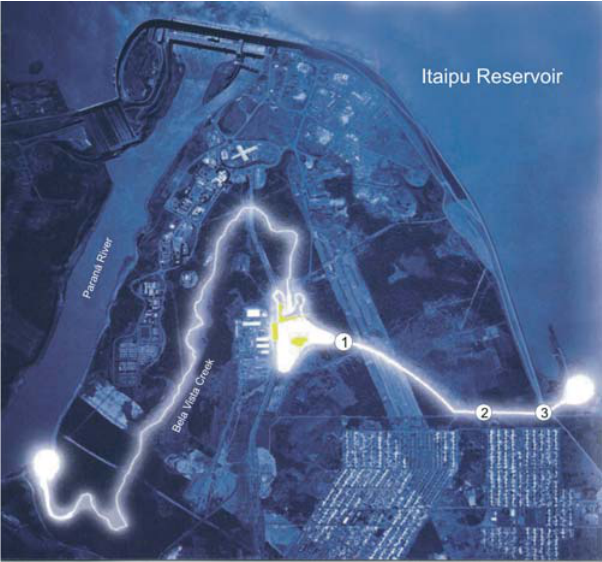
Fig. 1. Locations of the fixed-station receivers (numbers in- side the white circles) during the pilot study conducted in the lateral channel located near Itaipu